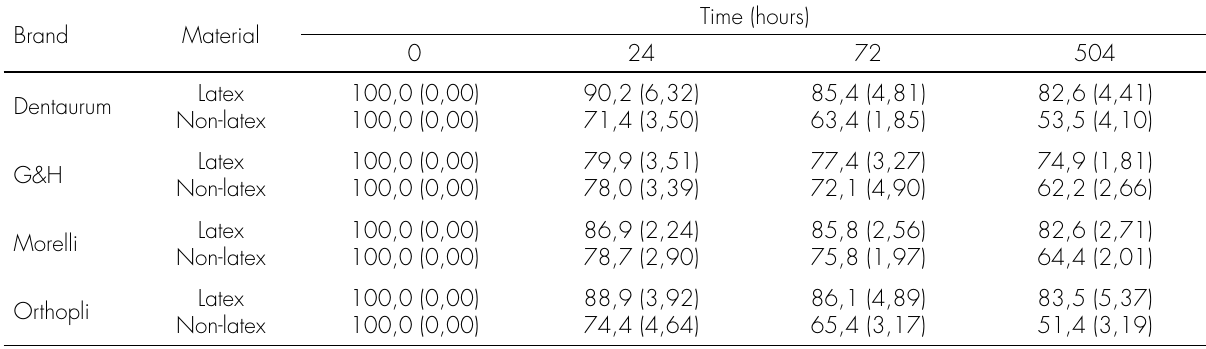
Table II. Mean and standard deviation of the remainig force percentage of the elastic latex and non-latex in evaluated periods.